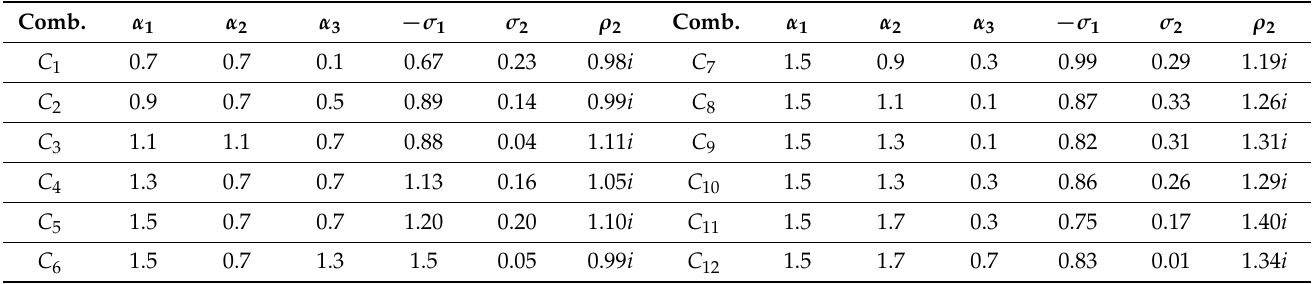
Table 2. Combinations of examined values that have Brownian-like motion based on the analysis performed. For each combination of values, its eigenvalues and the sum of these values are shown to confirm the dissipative conditions of the system. Consider the eigenvalues λ i , the real component σ i , and the corresponding imaginary component ρ i